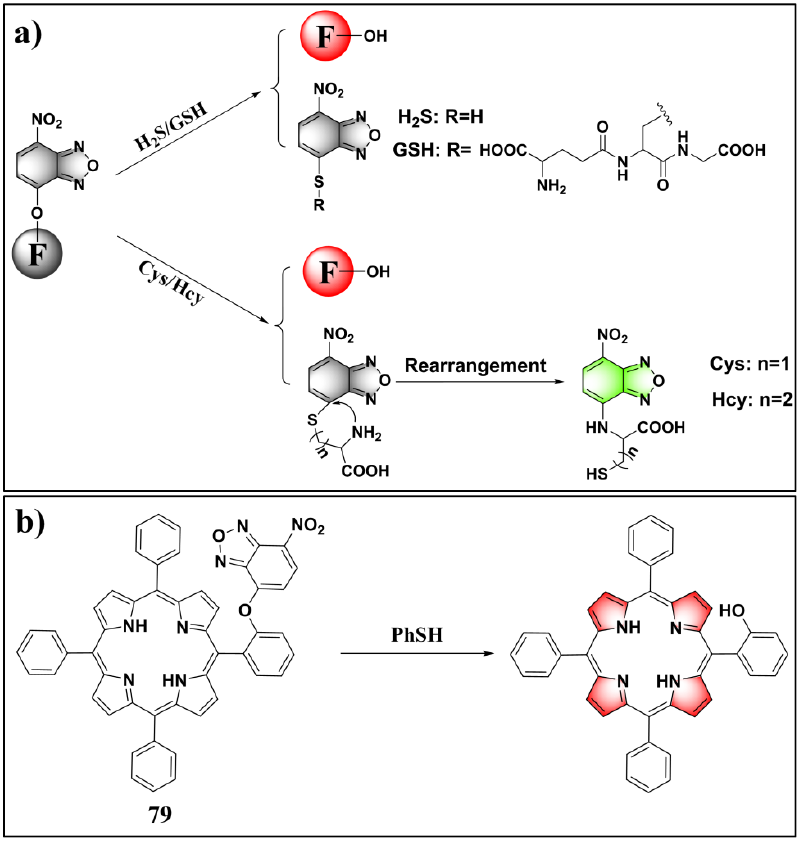
Figure 29. ( a ) Schematic illustration of nitrobenzoxadiazole (NBD)-appended dual-fluorophore system for differentiating H 2 S/GSH and Cys/Hcy. ( b ) Structure and reaction of probe 79 for PhSH.